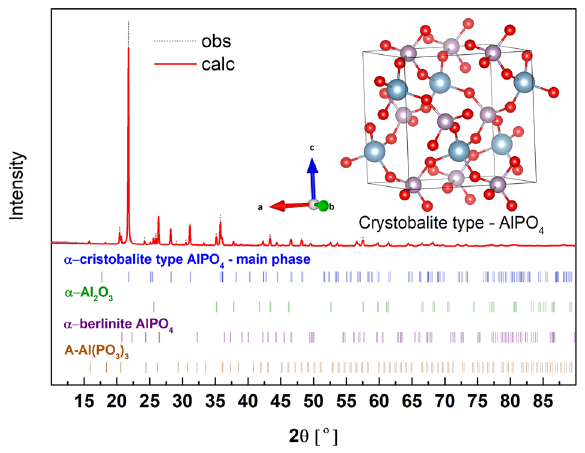
Figure 14. X-ray diffraction pattern (obs) and the fitted (calc) of α-cristobalite type AlPO 4 . Inset, the unit cell of the compound with the optimized atom positions.